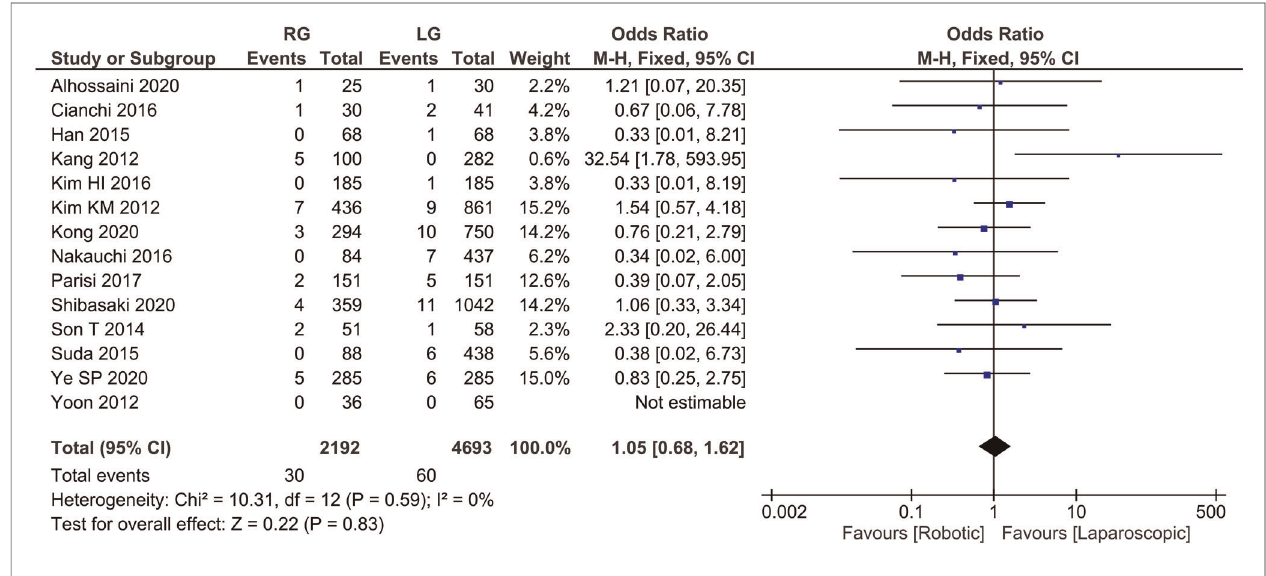
FIGURE 8 | Comparison of reoperation rate between RG and LG group.